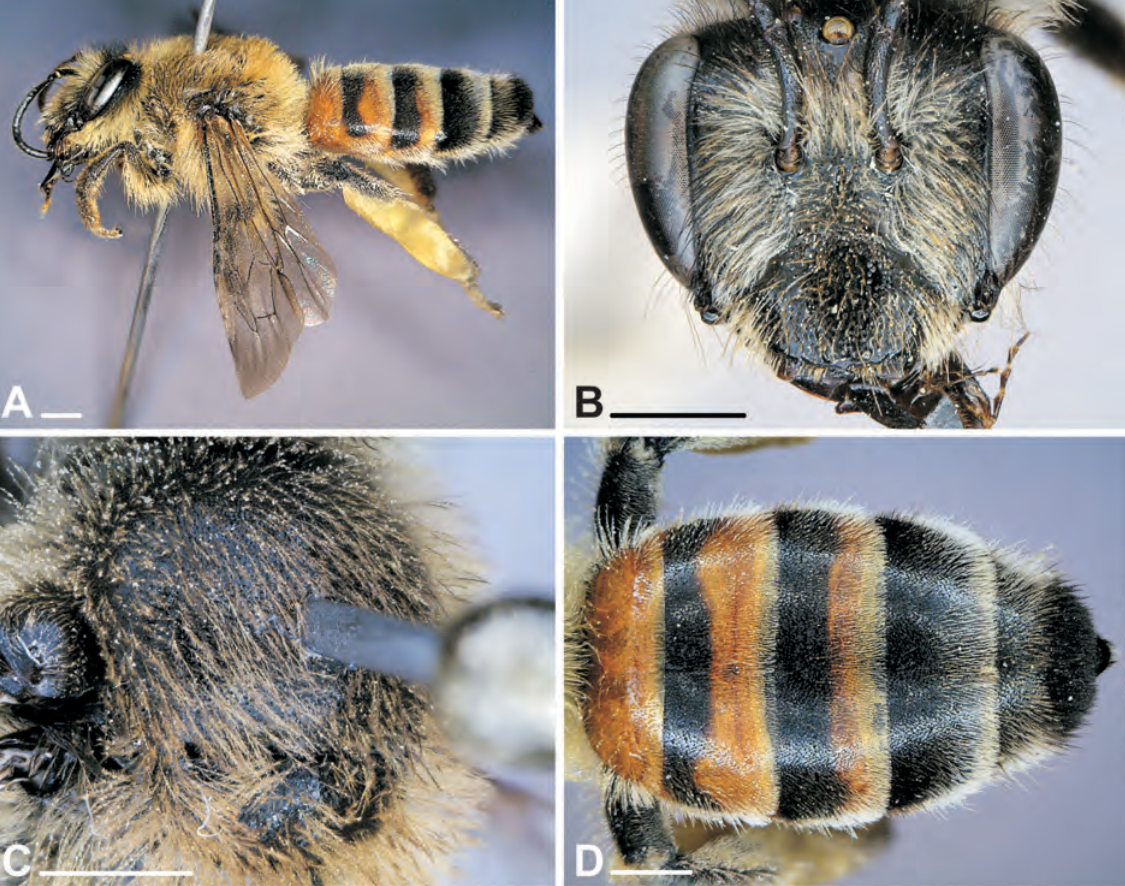
Fig. 12. Redivivoides simulans Michener, 1981, ♀. A . lateral view. B . head. C . Scutum and scutellum. D . Metasoma (dorsal view). Scale bar: 1